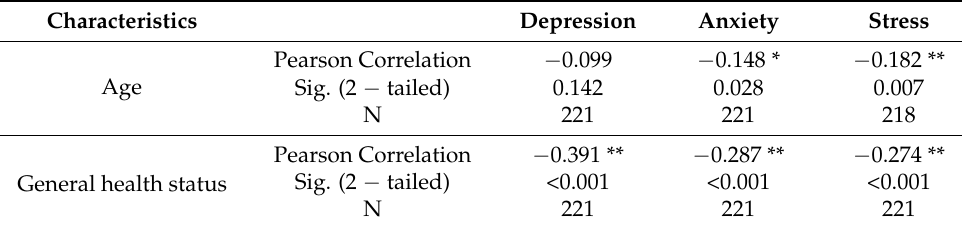
Table 4. Correlation between age and general health assessment with DASS-21 subscales.